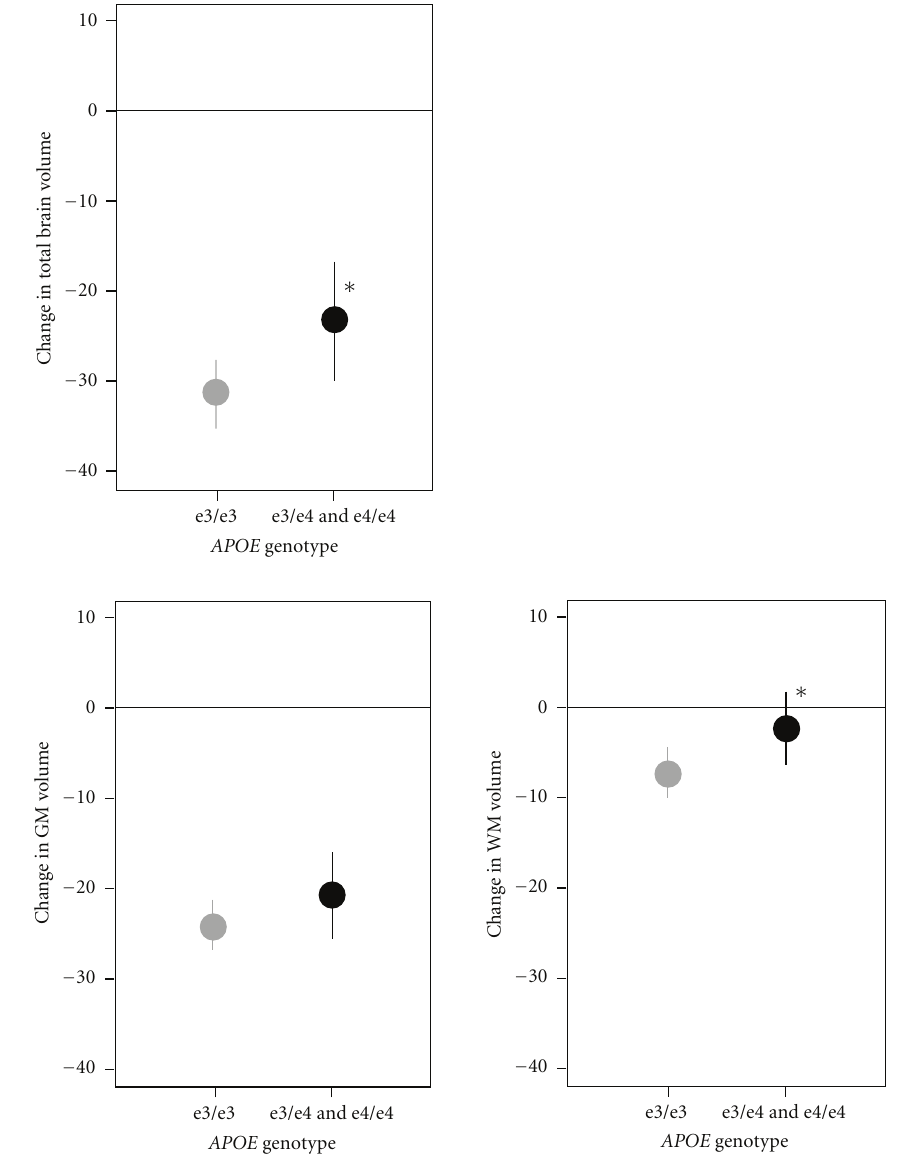
Figure 1: Change in total brain, GM, and WM volumes by APOE genotype. The grey and black lines are estimated change in volumes (mean ± 95% confidence interval) for the APOE ε 3/ ε 3 and APOE ε 3/ ε 4 + ε 4/ ε 4 groups, respectively. The asterisk indicates that the estimated change for the ε 3/ ε 4 + ε 4/ ε 4 group is significantly di ff erent than for the ε 3/ ε 3 group ( P <